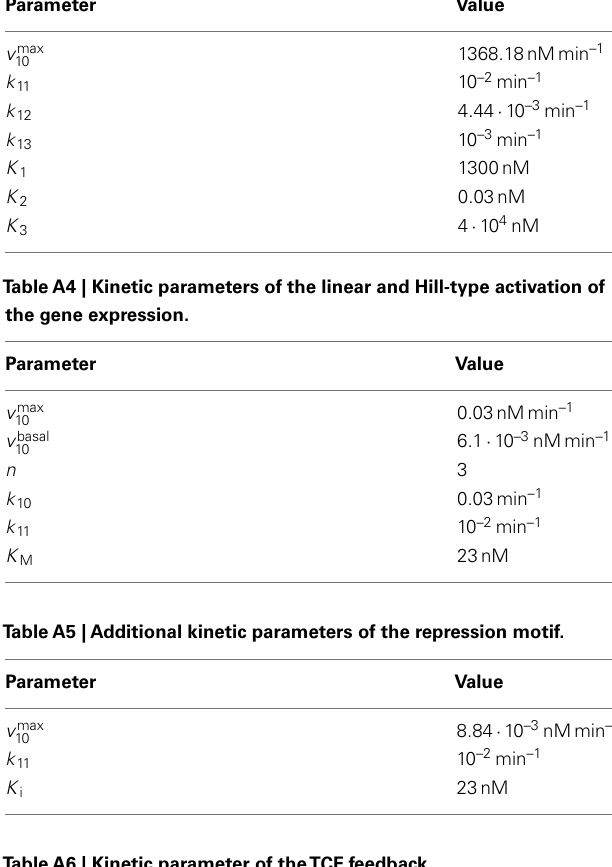
TableA6 | Kinetic parameter of theTCF